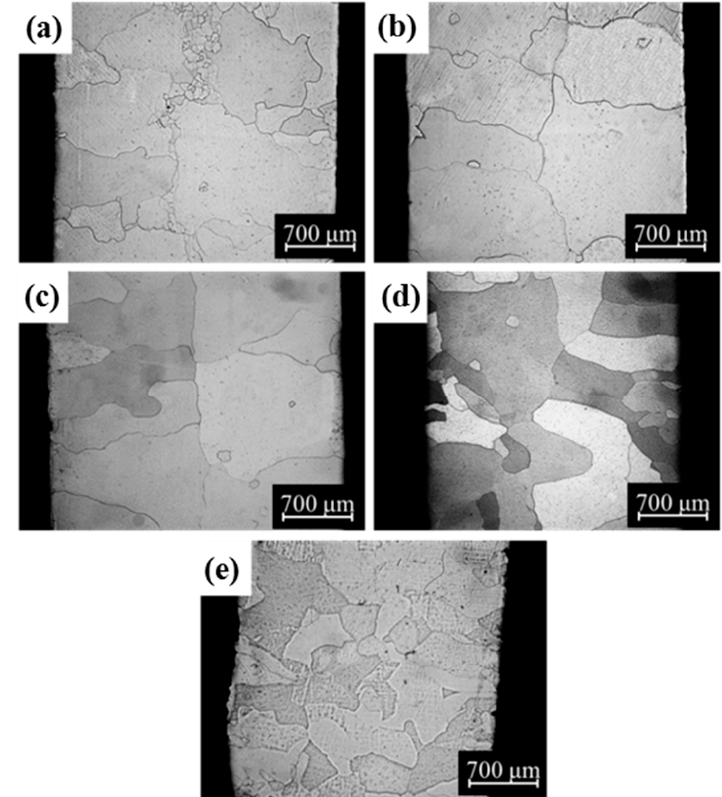
Figure 4. ( a ) Time to 710 ◦ C: 7.6 h, soaking time 72 h, ( b ) time to 740 ◦ C: 7.9 h, soaking time 42 h, ( c ) time to 850 ◦ C: 9.1 h, soaking time 0.25 h, ( d ) time to 960 ◦ C: 10.4 h, soaking time 0.25 h and ( e ) time to 1030 ◦ C: 12 h, soaking time 0.25 h. Micrographs were taken through the thickness of the strips.